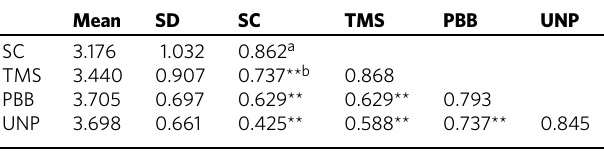
Table 1 Descriptive statistics and correlation